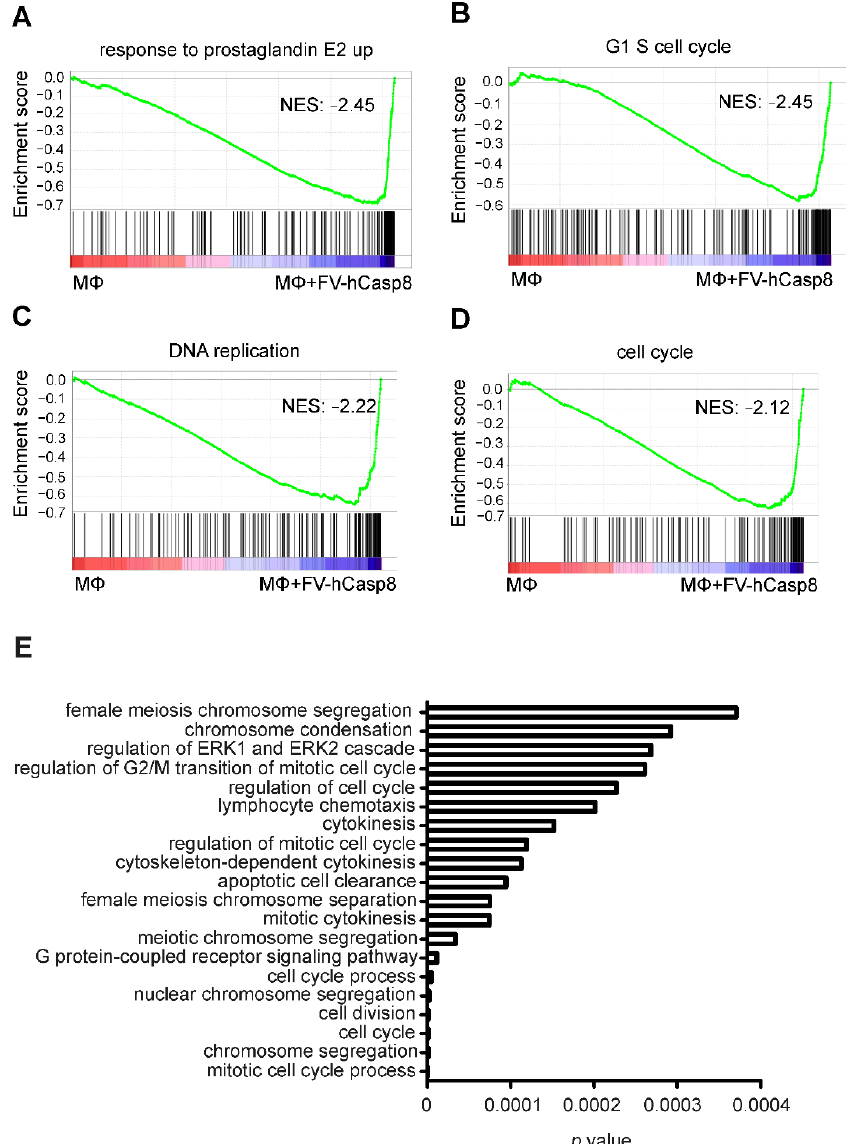
Figure 4. Macrophage pathways regulated by exposure to apoptotic cells. ( A – D ) Exemplary enrich- ment plots after gene set enrichment analysis are shown. GSEA shows enrichment of response to prostaglandin E2, G1 S cell cycle, DNA replication, and cell cycle pathways. Normalized enrichment scores (NES) can be found in the corresponding graph ( p value < 0.01, FDR < 0.01). ( E ) Top 20 upregulated pathways in macrophages co-cultured with apoptotic cells after GO analysis using GO Gorilla are